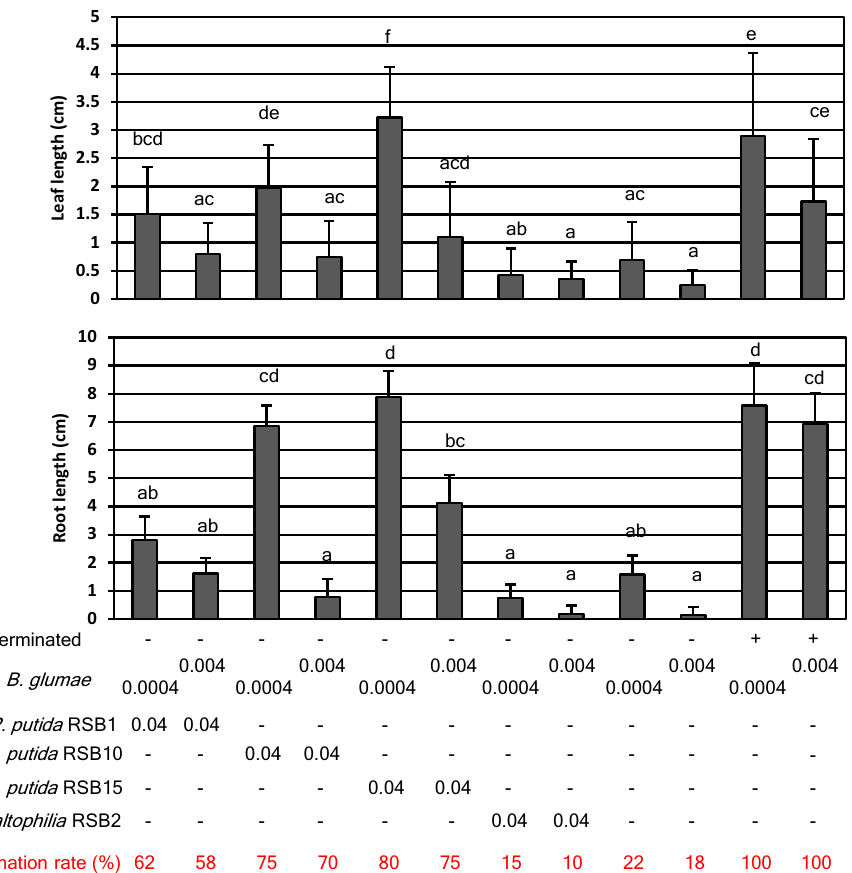
Figure 3. The growth inhibition caused by B. glumae was suppressed by P. putida RSB treatment. RSBs were inoculated on non-pregerminated rice seeds with or without B. glumae 301682, and leaf length (upper) and root length (bottom) was measured at 8 dpi (n = 25). Infection by B. glumae on pregerminated seeds is shown in the right two columns. Numbers under the figure show optical density of each bacteria in the inoculum. Statistical significance was subsequently determined through a TukeyHSD test (R software). Results are representative of three